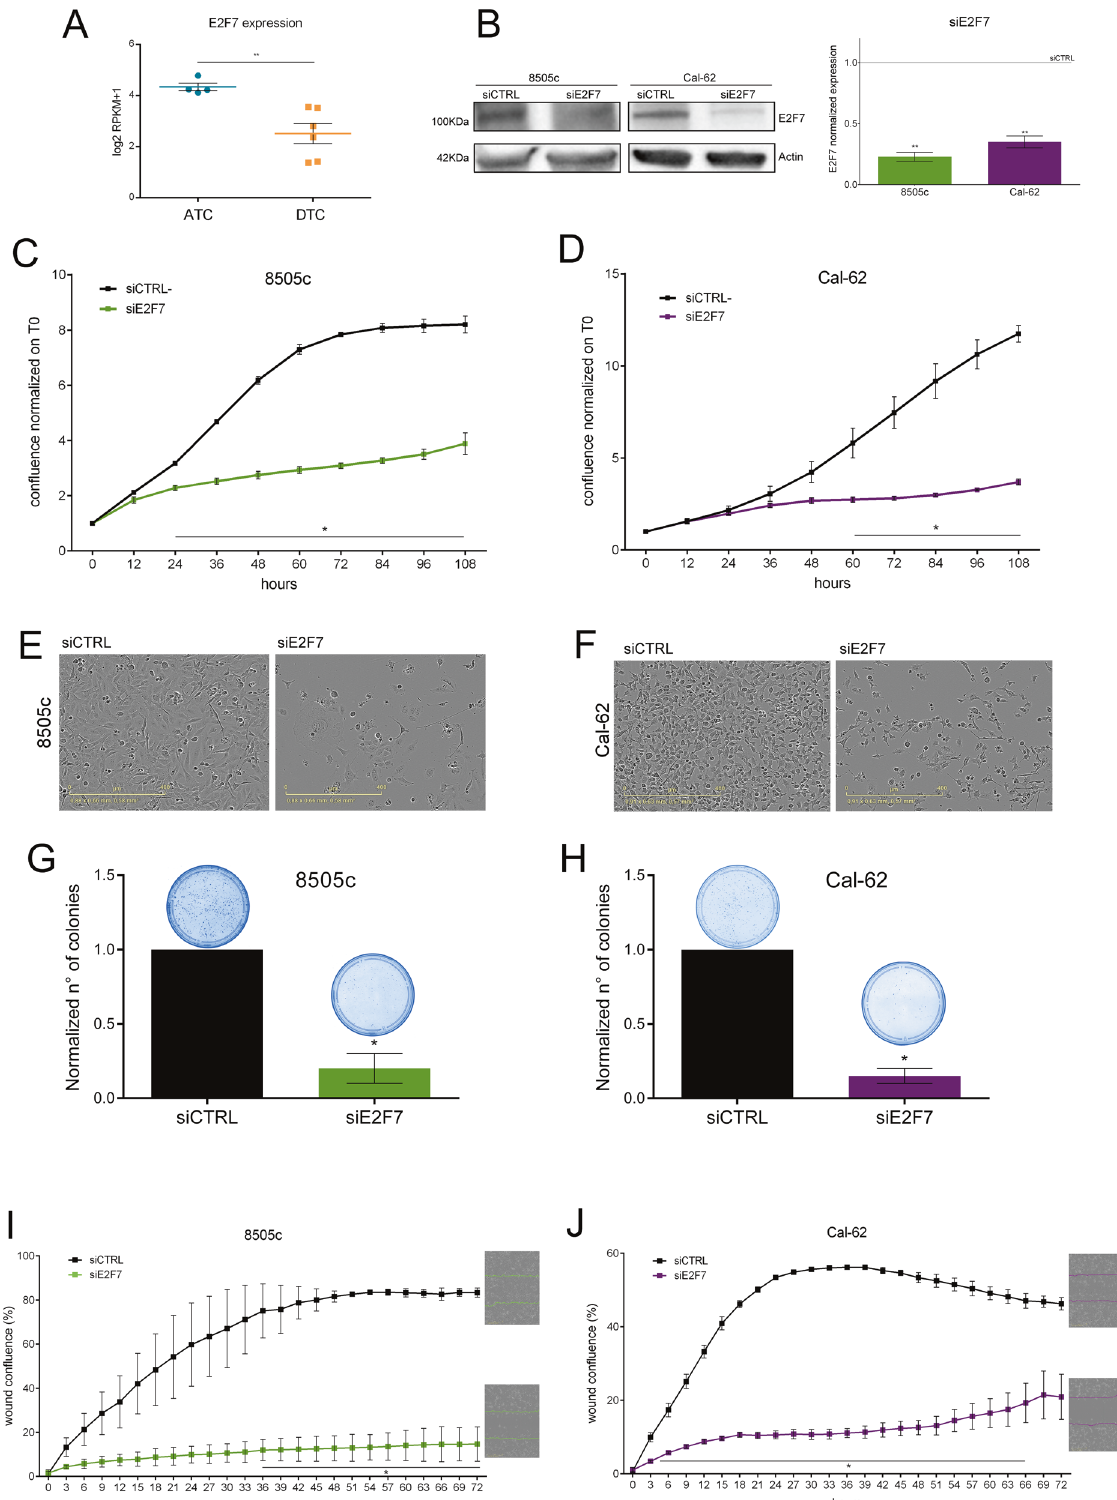
Fig. 3 E2F7 is required for cell division progression in ATC. A , B Assessment of E2F7 expression in different ATC and DTC cell lines from the CellMiner database, expressed as log2RPKM A and in 8505c and Cal-62 cells 48 h after E2F7 silencing by qRT-PCR and Western blot B . Effects of E2F7 KD on proliferation C , D , cell morphology E , F , colony formation G , H , and migration I , J of 8505c and Cal-62 cells. Light microscopy representative images show cells at experimental endpoint (108 h for proliferation and 72 h for migration) with scale bar of 400 µm. Graphics represent means and SD of two independent biological replicates * p < 0.05, ** p < 0.005.